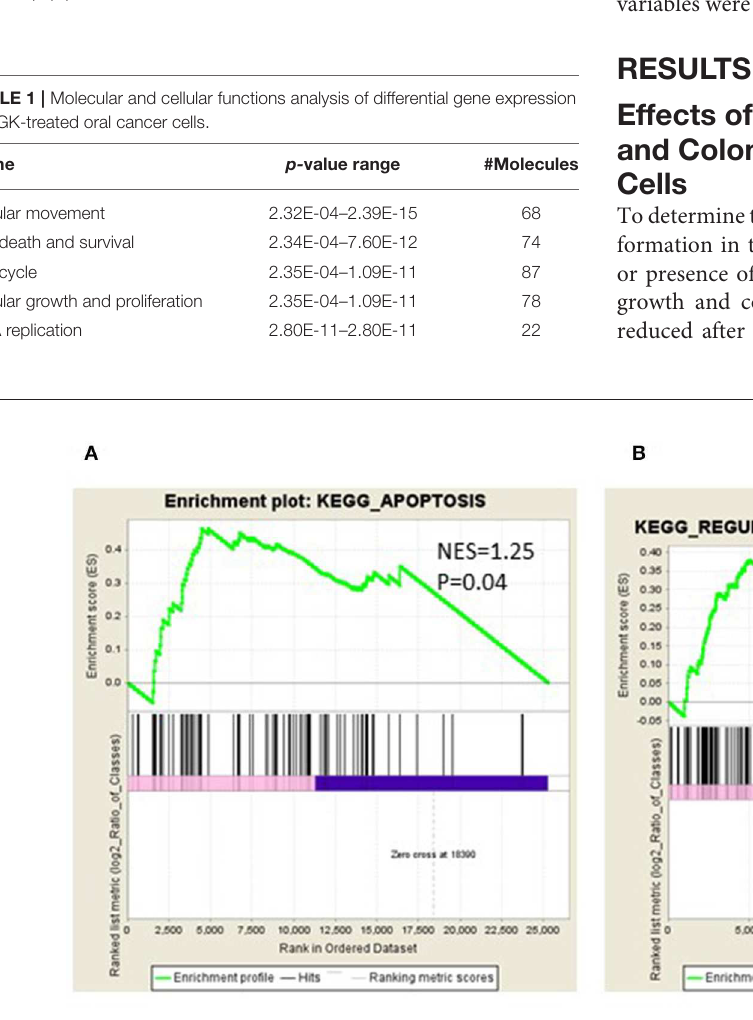
FIGURE 3 | Gene Set Enrichment Analysis (GSEA) enrichment plot involved in (A) apoptosis (B) in regulation of actin cytoskeleton.